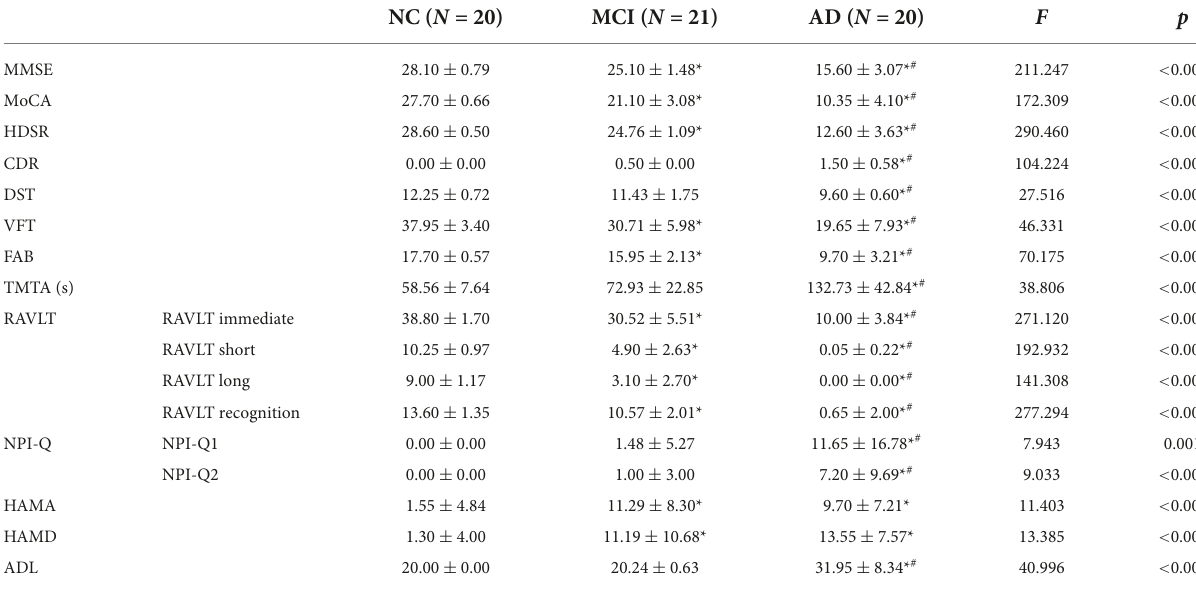
TABLE 4 Neuropsychological test